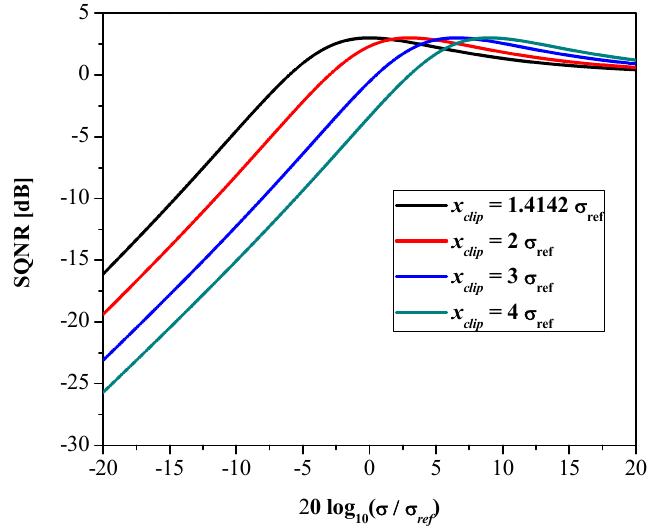
Figure 6. Signal-to-quantization noise ratio (SQNR) as a function of input signal variance for binary quantizer type 1.